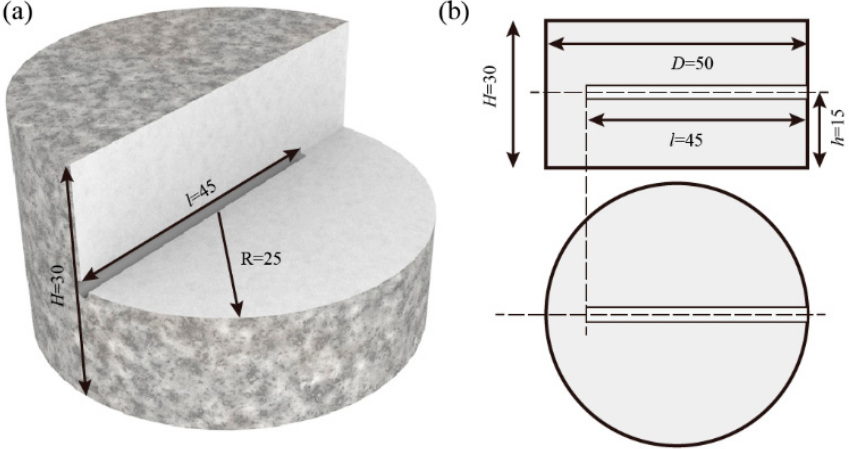
Figure 2. Schematic diagram of disc-shaped sample with holes. ( a ) Section view ( b ) Side view and top view.